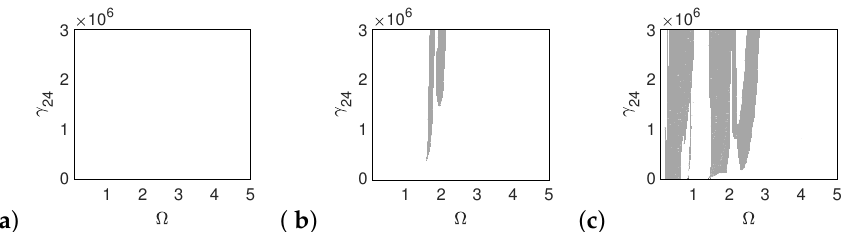
Figure 7. Regions of polyharmonic vibrations of the stapes for the case of the normal ear versus the nonlinear stiffness rate of the coupler ( γ 24 ) and the excitation frequency ( Ω ) under the excitations p ( a ), 5 p ( b ) and 10 p ( c ).